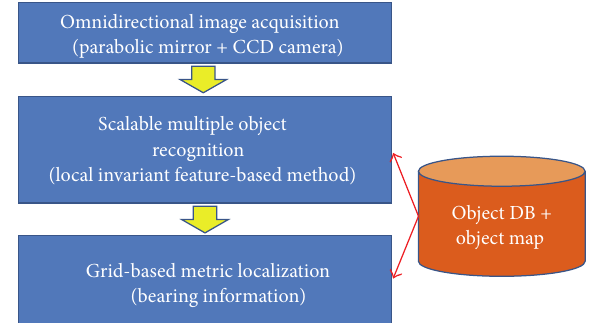
Figure 3: Proposed novel paradigm of localization using high-level object information: given the object database and object-based map, robot location is estimated through the object recognition module and bearing measurement-based localization